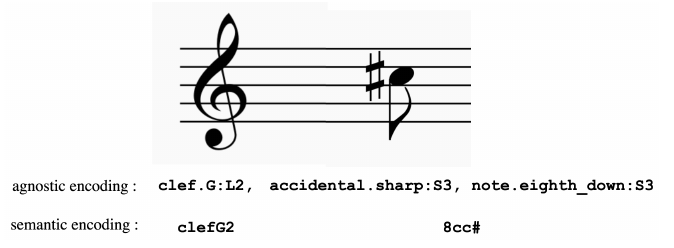
Figure 5. An example of an agnostic encoding and its translation into a **kern ∗ semantic